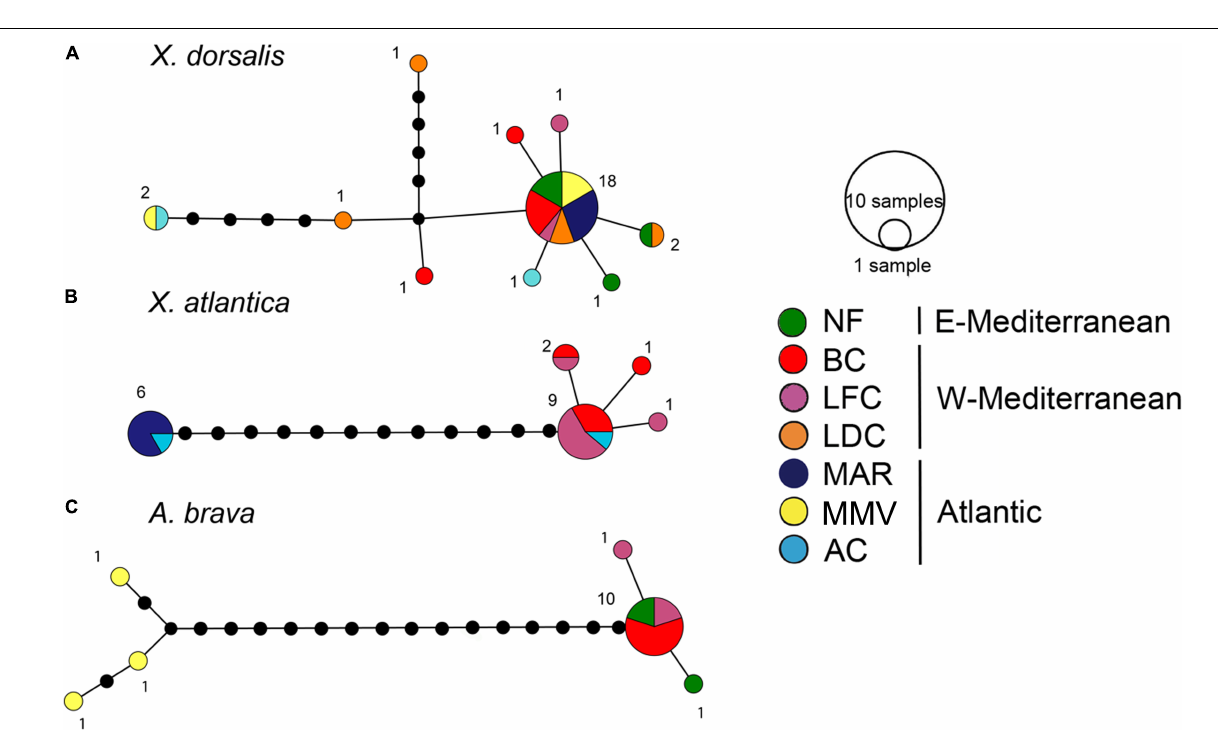
FIGURE 6 | COI haplotype networks. (A) Xylophaga dorsalis (388 bp, 29 individuals). (B) Xylonora atlantica new comb. (388 bp, 19 individuals). (C) Abditoconus brava (389 bp, 15 individuals). Location colors as in Figure 1 , except for MAR = Menez-Gwen hydrothermal vent filed at Mid-Atlantic Ridge, for location abbreviations see Figure 1